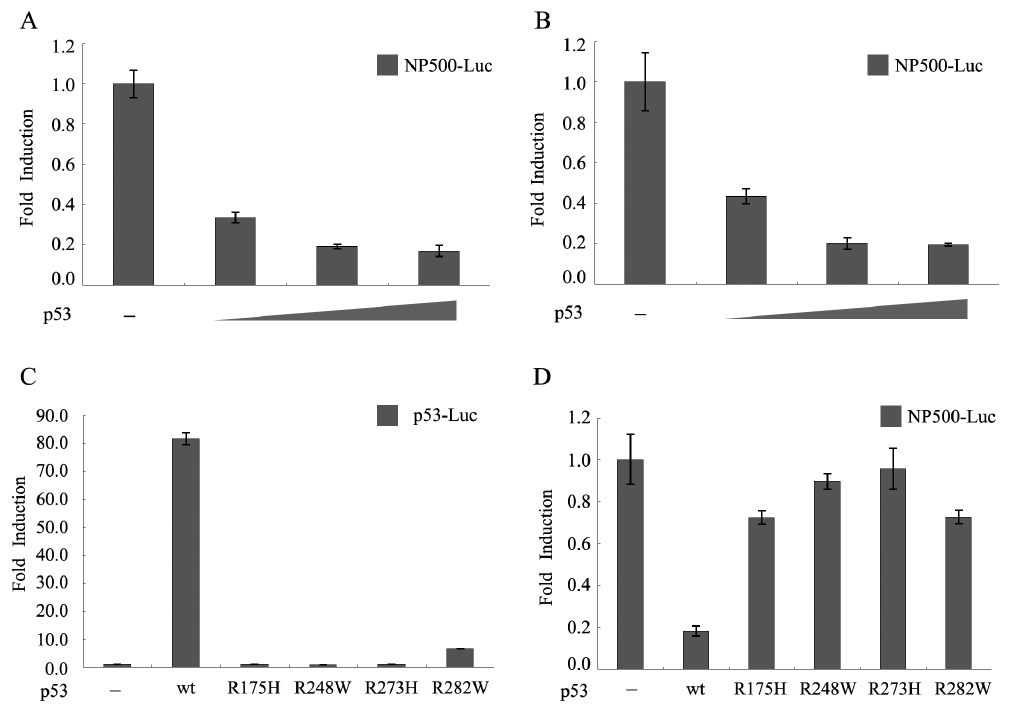
Figure 1. Dose-dependent repression of the RLIM promoter by p53. ( A ) H1299 cells or ( B ) Hep3B cells were cotransfected with 100 ng of RLIM promoter-luciferase reporter construct NP500-Luc, 30 ng pRL-SV40 and increasing amounts (0, 1, 2.5 and 10 ng) of pCMV-HA-p53 plasmids. The total amount of plasmid in each transfection was adjusted to be the same using the empty vector. Cells were harvested 30 h after transfection and lysed for measuring luciferase activity. Data represent the mean of three independent experiments normalized to pRL-SV40 activity and are presented as fold of induction; bars, 6 S.D. ( C ) Various p53 expression constructs (wild type and mutants with mutations in codons 175, 248, 273 and 282) or pCMV-vector plasmid were cotransfected with 100 ng of p53-Luc luciferase reporter gene (Stratagene). Cells were harvested 30 h after transfection and lysed for luciferase assays. ( D ) Effects of p53 and various mutants on RLIM promoter activity. The indicated p53 expression plasmids or pCMV- vector plasmid were transfected with 100 ng of RLIM promoter-luciferase plasmid NP500-Luc. Cells were harvested 30 h after transfection and lysed for luciferase assays.